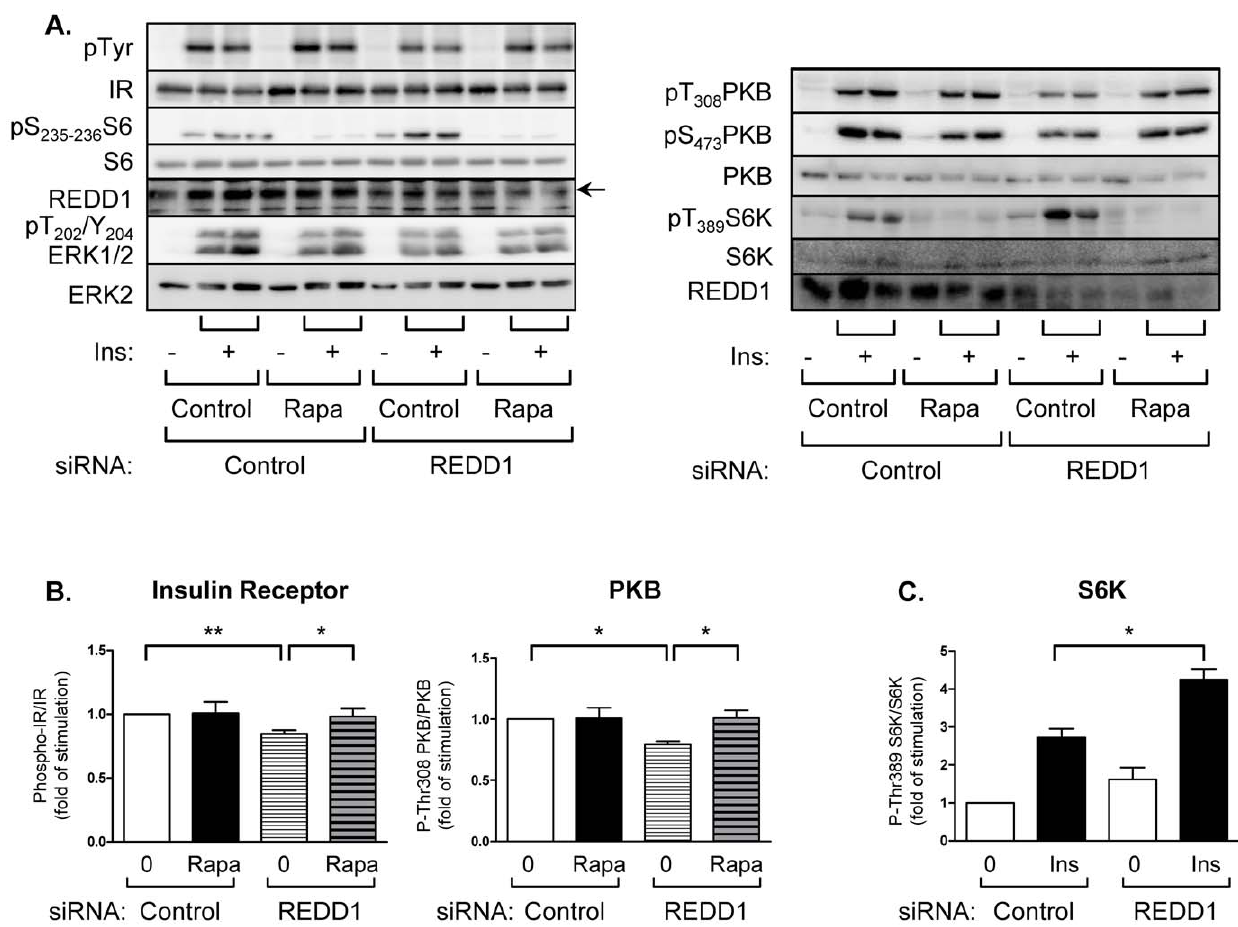
Figure 8. Inhibition of insulin receptor phosphorylation is dependent of mTOR activity. (A) 3T3-L1 adipocytes were transfected with REDD1 siRNA. 48 h after transfection, adipocytes were pretreated with rapamycin (40 nM) for 1 hour before being stimulated with insulin for 5 minutes. Proteins were analyzed by immunoblots using indicated antibodies. (B) Quantification of phosphorylation of insulin receptor (n=8), pThr308-PKB (n=3) in insulin-induced conditions is shown. (C) Quantification of phosphorylation of pThr389-S6K (n=3) is shown (*p , 0.05, **p , 0.01).